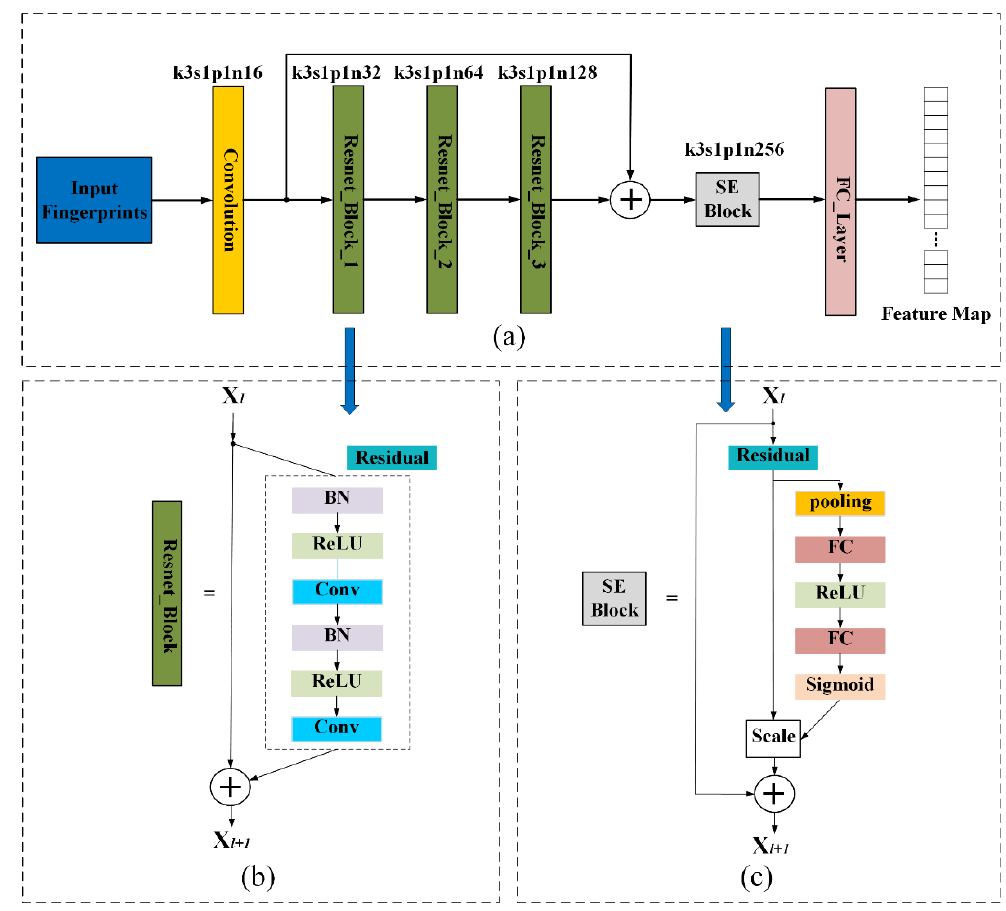
Figure 2. ( a ) is the structure of feature extraction network model, ( b ) is the detail of the residual block, ( c ) is the SE block, respectively.